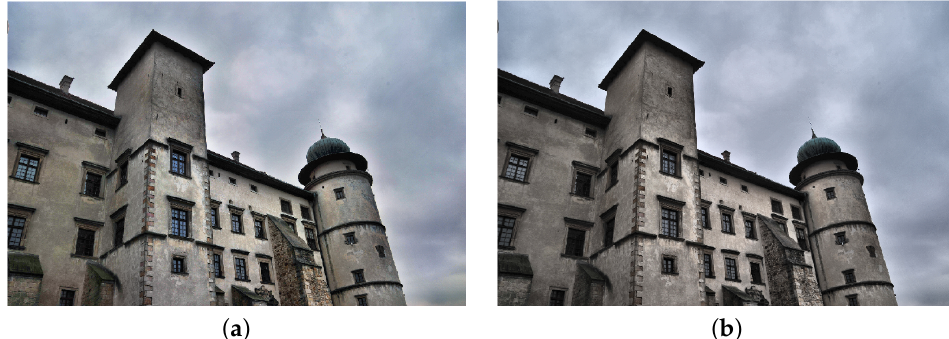
Figure 7. Image transformed with the use of adaptive histogram equalizing in RGB ( a ) and L*a*b* space ( b ).